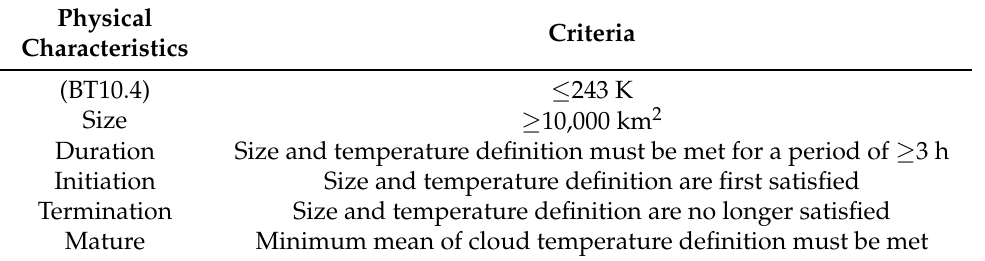
Table 2. Criteria of MCS defined in this